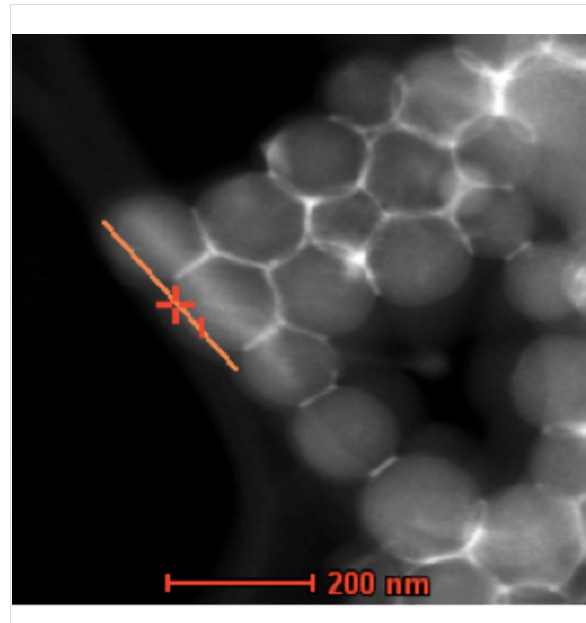
Figure 7: HAADF-STEM image of a line scan of a length of 200 nm . The red artificial marking line indicates the scan direction from left to lower right. The original line scan of the e-beam was in the middle of the Stoeber spheres (note the brighter contrast line running along the surface of the first three Stoeber spheres).